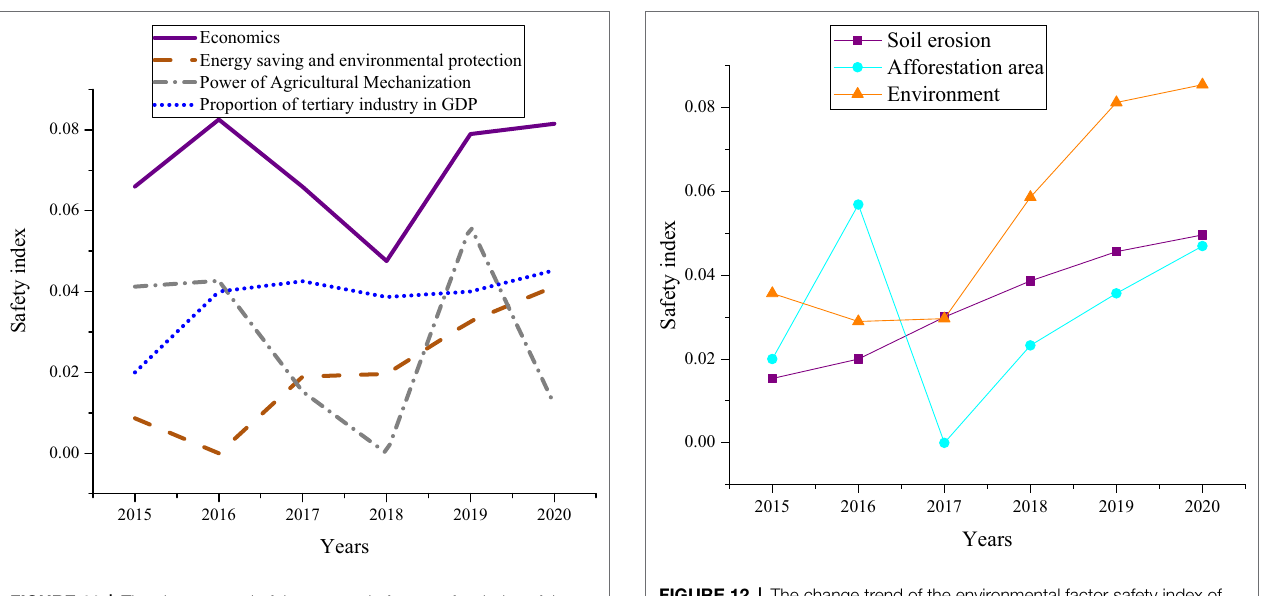
FIGURE 11 | The change trend of the economic factor safety index of the food safety response subsystem during 2015–2020.